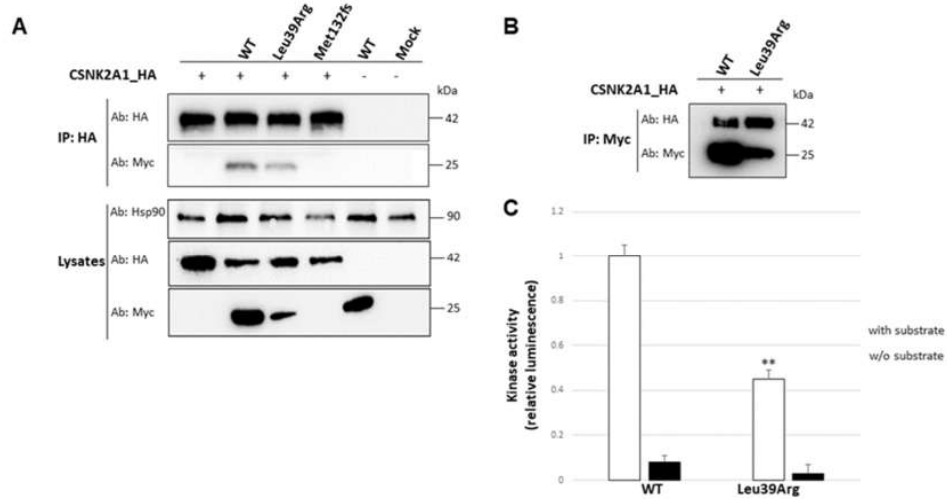
Figure 10. Impact of CSNK2B mutations on CK2 subunits’ interaction and kinase activity. ( A ) HEK293 cells were transiently co-transfected with CSNK2A1 -HA and the Myc-tagged CSNK2B wild type and mutants. Protein complexes were immunoprecipitated using an anti-HA antibody. Proteins were subjected to SDS–PAGE gel and immunoblotted with an anti-Myc antibody and an anti-HA antibody. Total cell lysates from co-transfected and non-transfected cells (mock) were probed with anti-Myc, anti-HA and anti-Hsp90 as a loading control. ( B ) Measure of the kinase activity of wild type (WT) and mutant (Leu39Arg) CK2beta proteins. CSNK2B wild-type and mutant